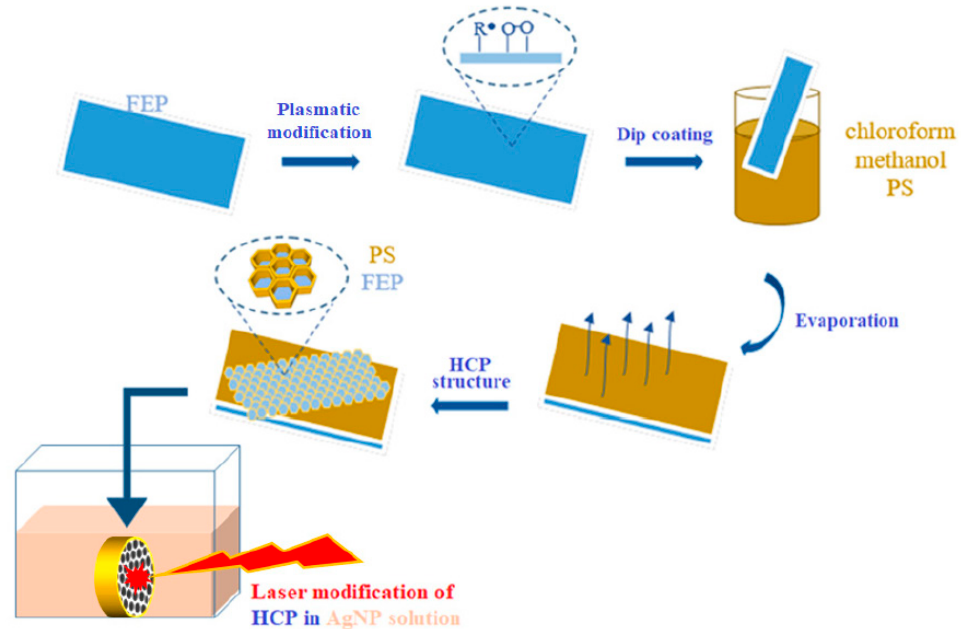
Figure 12. Scheme of the preparation of a honeycomb pattern immobilized with Ag nanoparticles. [164].